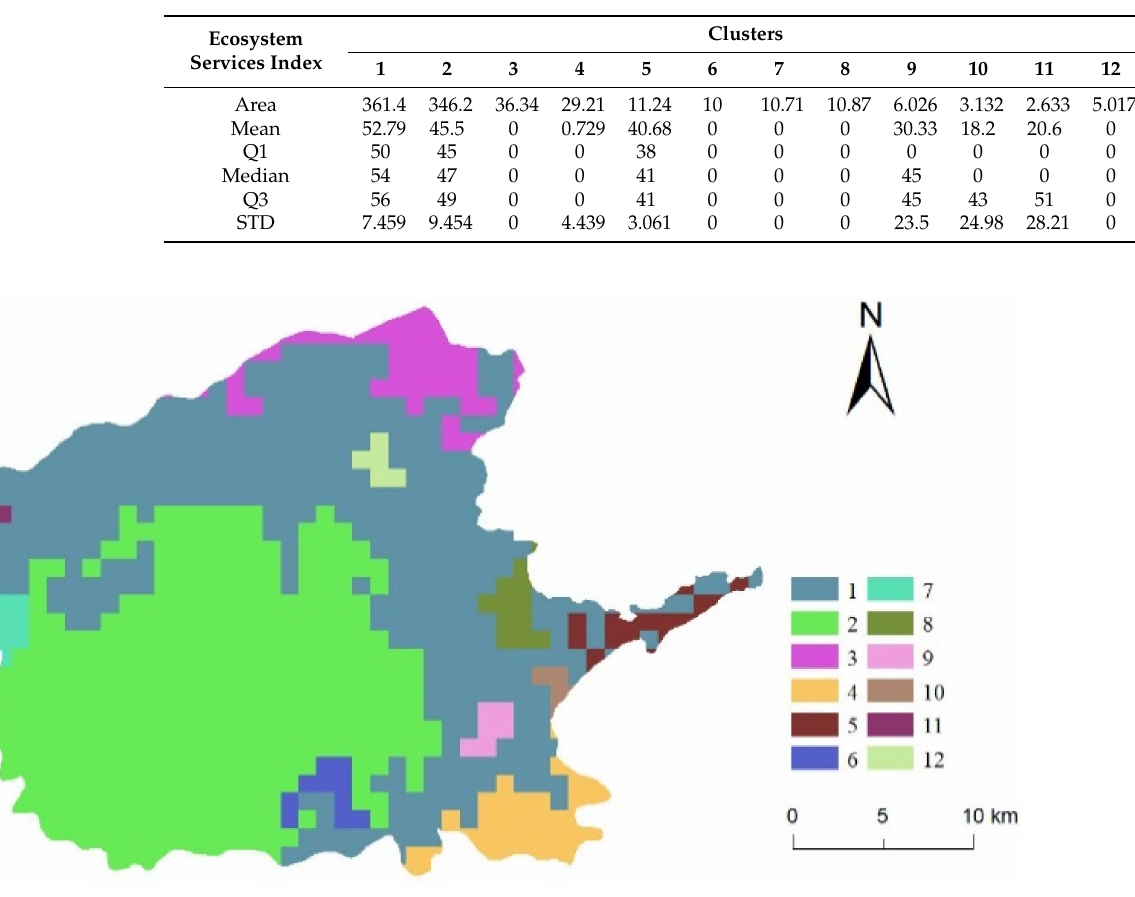
Table 3. Statistics of homogeneous regions.